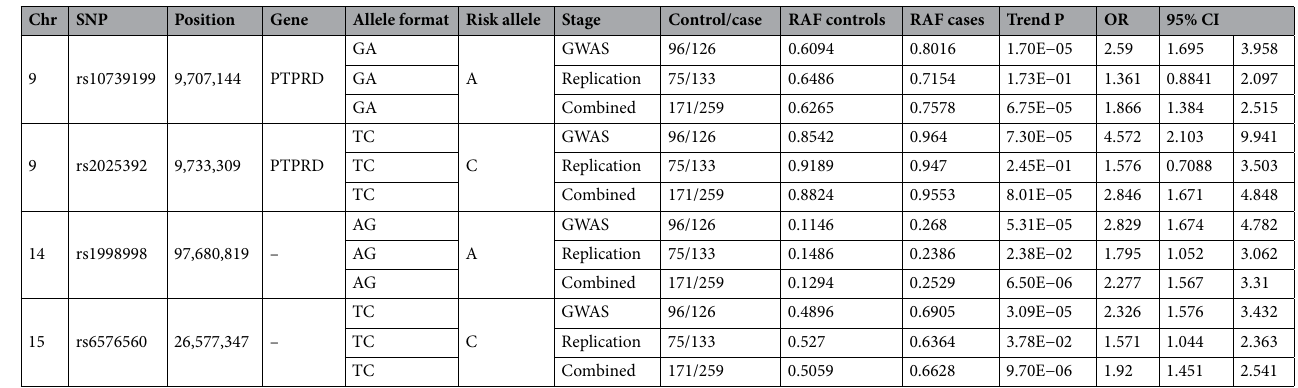
Table 2. SNPs with P values < 1 × 10 –4 in joint analysis. RAF risk allele frequency, Trend P P vale of Trend test, OR odds ratio, CI confidence